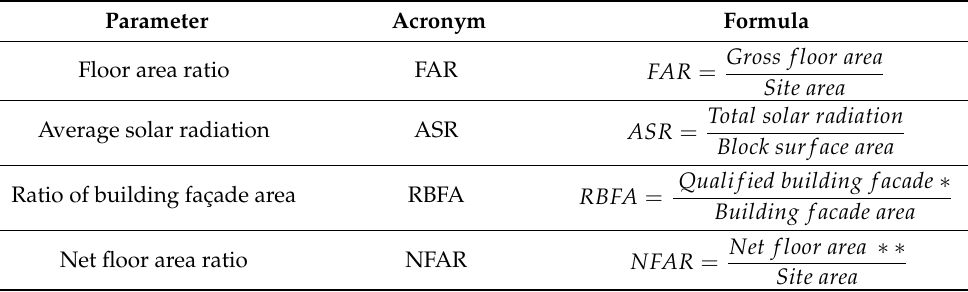
Table 2. Formulae for this